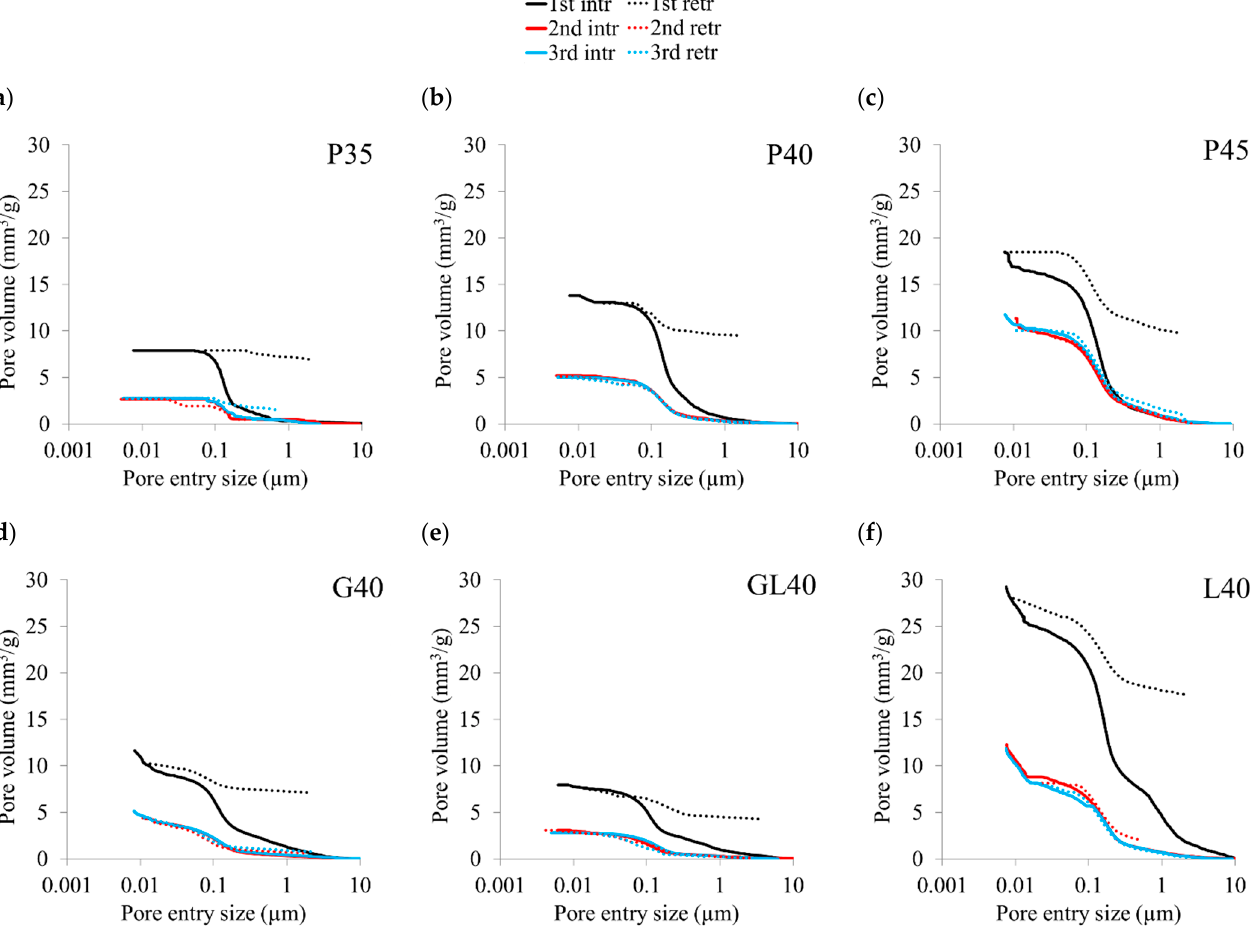
Figure 2. Cumulative curves for the multicycle MIP for mixes ( a ) P35, ( b ) P40, ( c ) P45, ( d ) G40, ( e ) GL40 and ( f ) L40.